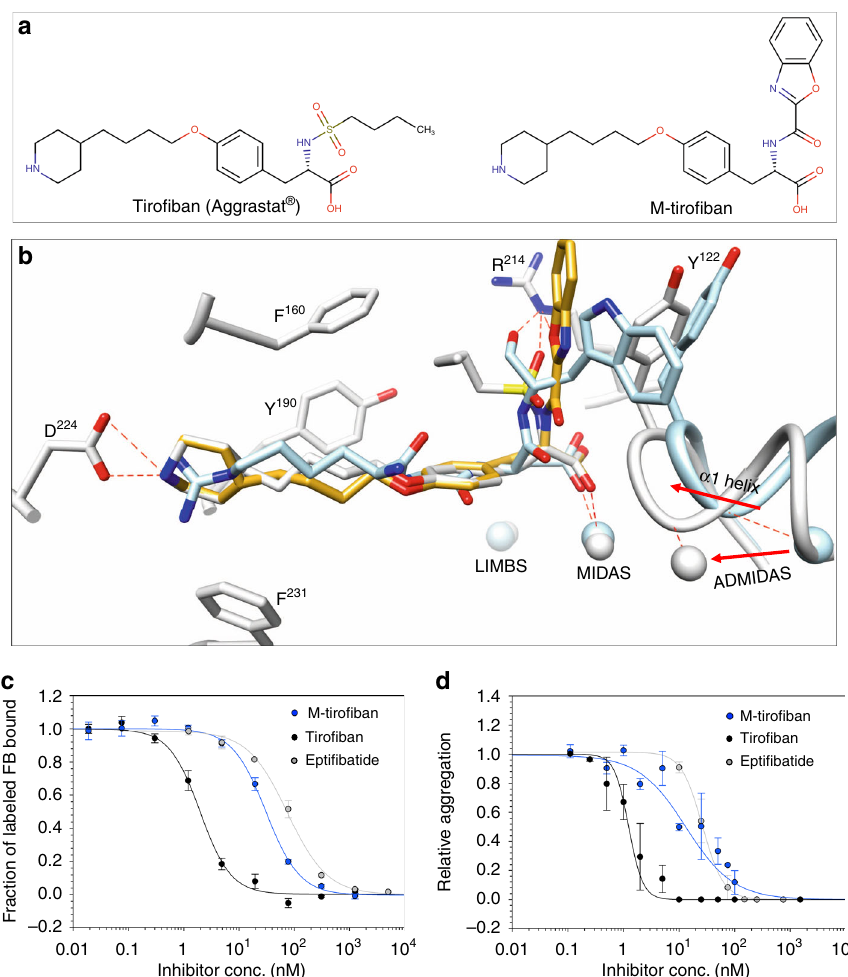
Fig. 7 Engineering and in vitro activities of M-tiro fi ban. a Chemical structure of tiro fi ban and M-tiro fi ban (see also Supplemental Fig. 4). b A model of bound M-tiro fi ban (gold) superposed on the structures of tiro fi ban/ α IIb β 3 (gray, 2vdm.pdb) and the present α V β 3/Hr10 structure (light blue). The β A domain of each was used in superposition. The metal ions at LIMBS, MIDAS, and ADMIDAS and relevant residues are shown in the respective colors. Contacts are shown as dotted red lines. See text for details. c Dose – response curves (mean + / − s.e., n = 4 experiments) showing displacement of labeled FB bound to preactivated α IIb β 3-K562 by tiro fi ban or M-tiro fi ban, yielding IC 50 s of 1.98 + / − 0.19 nM and 30.9 + / − 3.3 nM, respectively. Displacement of labeled FB by epti fi batide (73.2 ± 7.0 nM; Fig. 2c) is added for comparison. d Dose – response curves (mean + / − s.e.) showing effects of tiro fi ban and M-tiro fi ban on human platelet aggregation from three different donors (three tiro fi ban and fi ve M-tiro fi ban determinations) induced by ADP (20 μ M), yielding IC 50 s of 1.41 + / − 0.23 nM and 18.5 + / − 5.4 nM, respectively, in comparison with epti fi batide (26.3 + / − 2.8 nM; Fig.